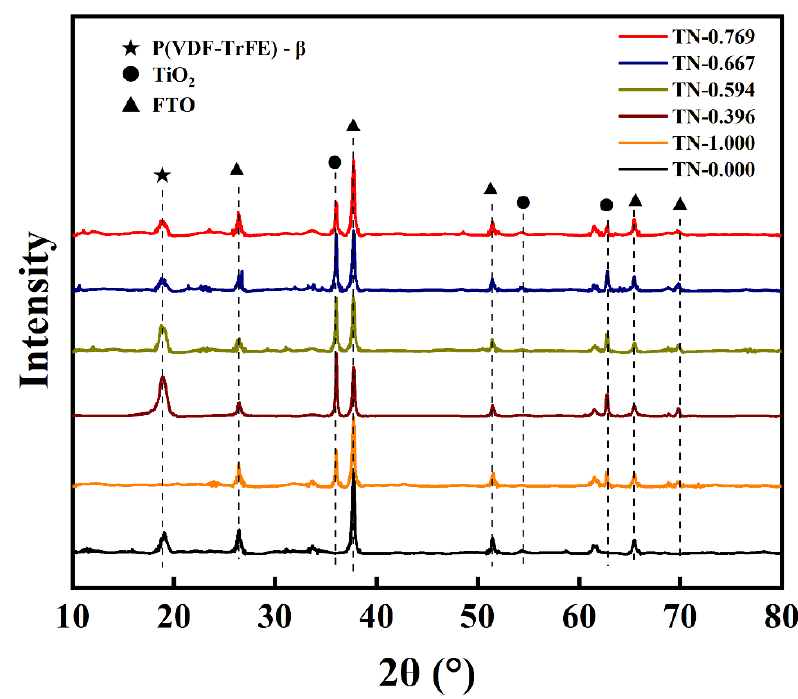
Figure 4. XRD patterns of composite TN-0.769, TN-0.667, TN-0.594, TN-0.396, TN-0.000 and TN- 1.000.